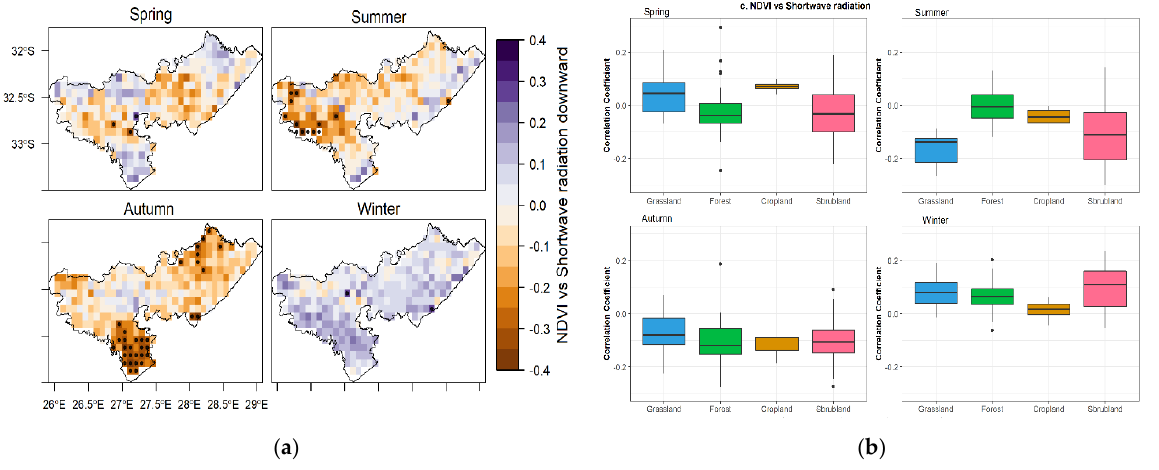
Figure 7. ( a ) Pixel-wise partial correlation coefficients between the NDVI3g and the ERA5-Land shortwave radiation downward for Amathole District Municipality; and ( b ) boxplots of correlation for vegetation types. The stipplings are for pixels with statistical significance ( p -value < 0.05).